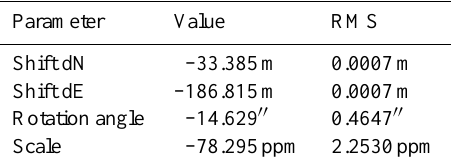
Table 2. Transformation parameters from D¨uzce to Bolu, piers 1 to 35.